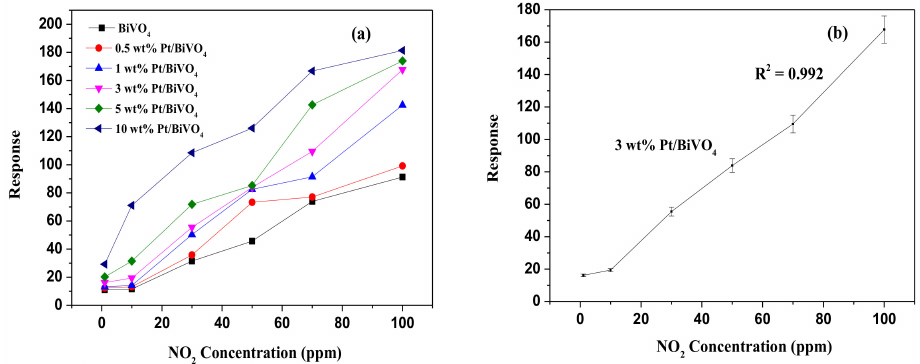
Figure 4. ( a ) Discrepancies in response relative to variations in 1–100 ppm NO 2 for varying Pt/BiVO 4 nanocomposites contents. ( b ) Response of the 3wt.% Pt/BiVO 4 sensor to 1–100 ppm NO 2 at room